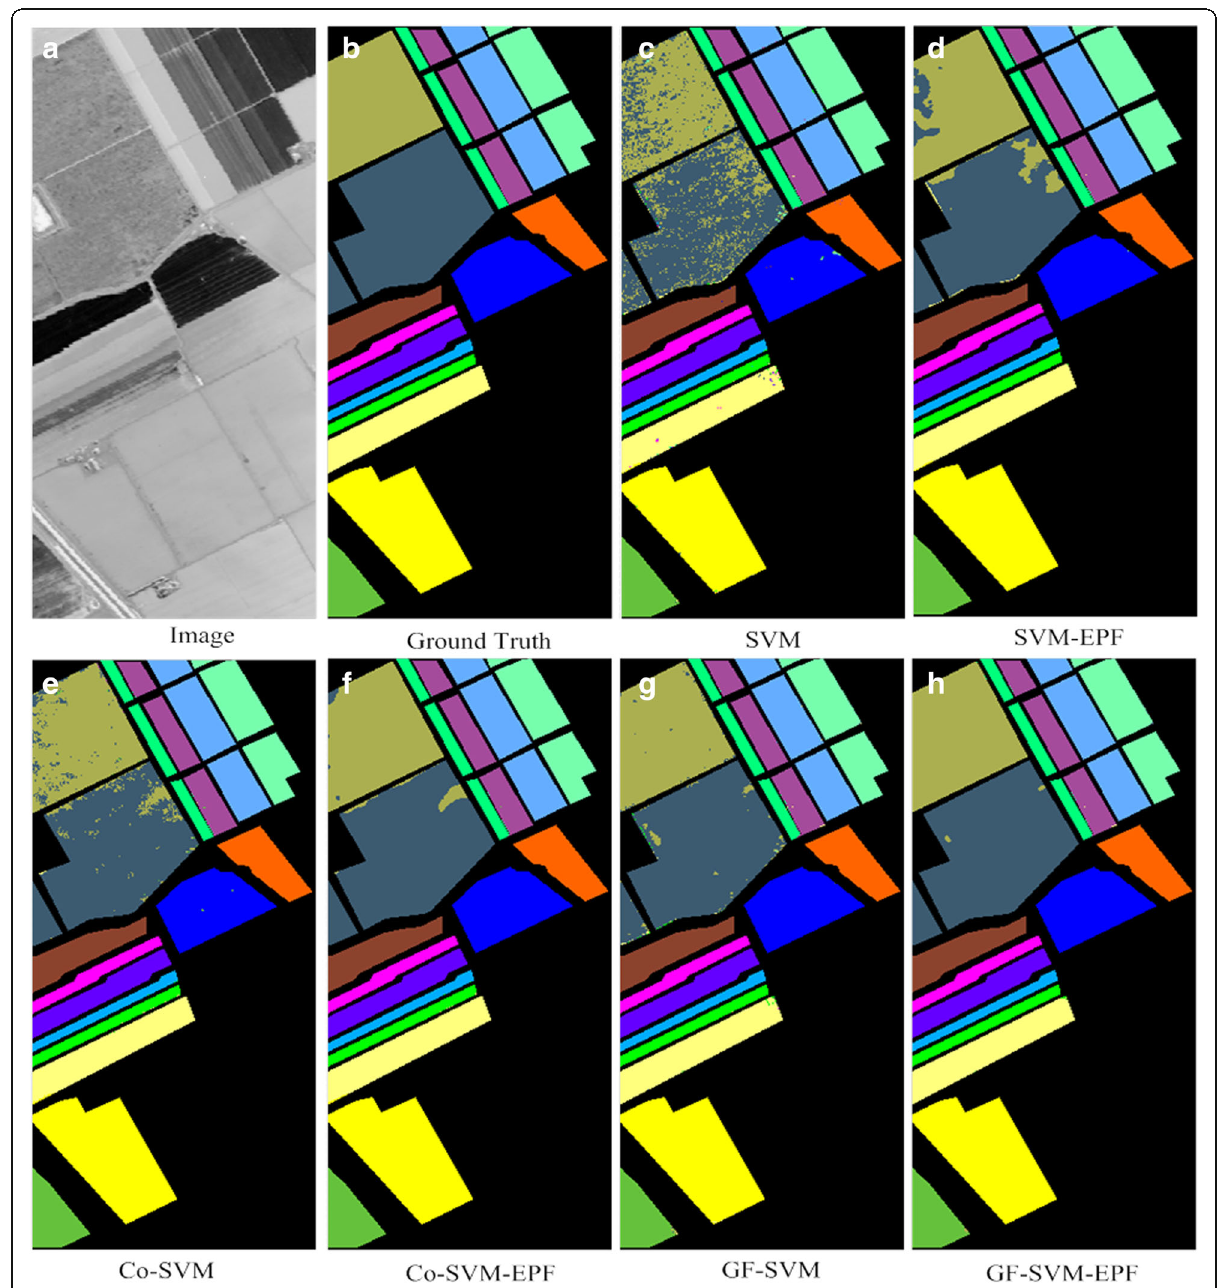
Fig. 4 Qualitative results on the Salinas dataset. a Image. b Ground truth. c SVM. d SVM-EPF. e Co-SVM. f Co-SVM-EPF. g GF-SVM. h